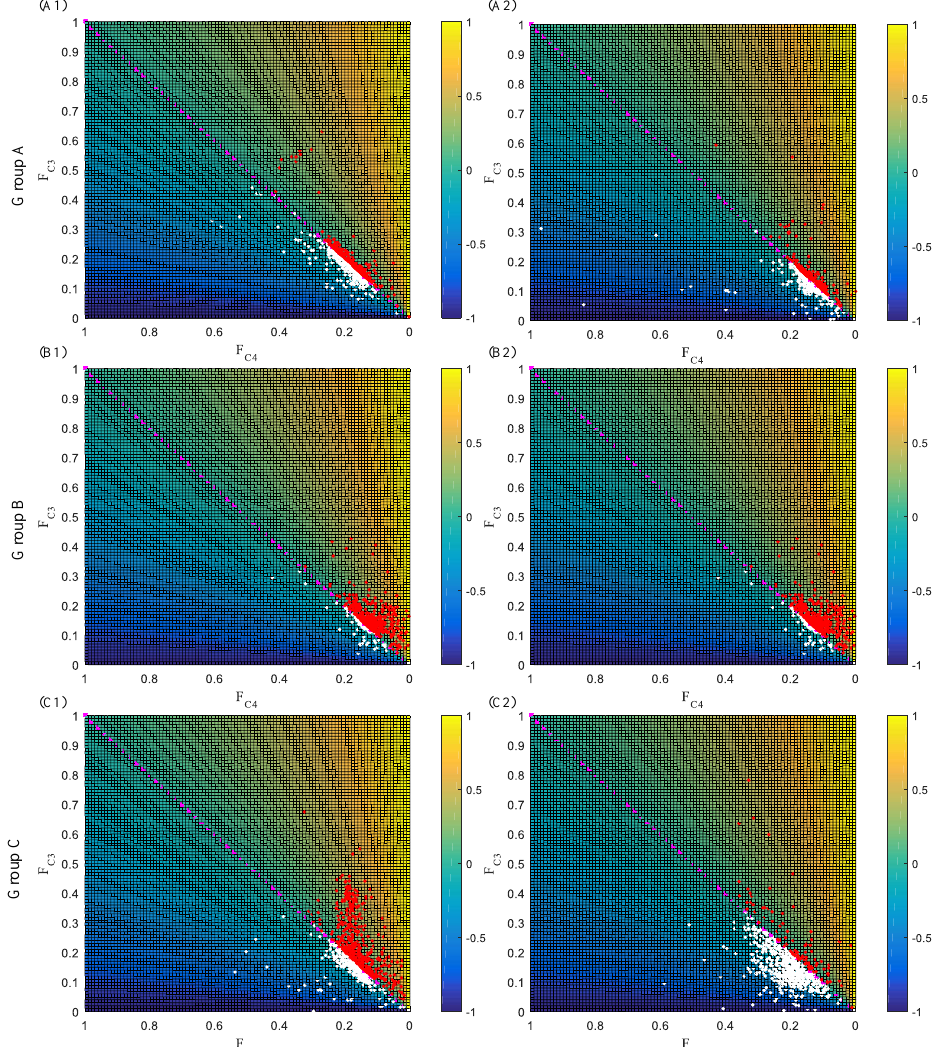
Figure 5. LI distribution for three groups. Group A: (A1) ucddb015, (A2) ucddb022. Group B: (B1) ucddb002, (B2) ucddb013. Group C: (C1) ucddb025, (C2) ucddb028.